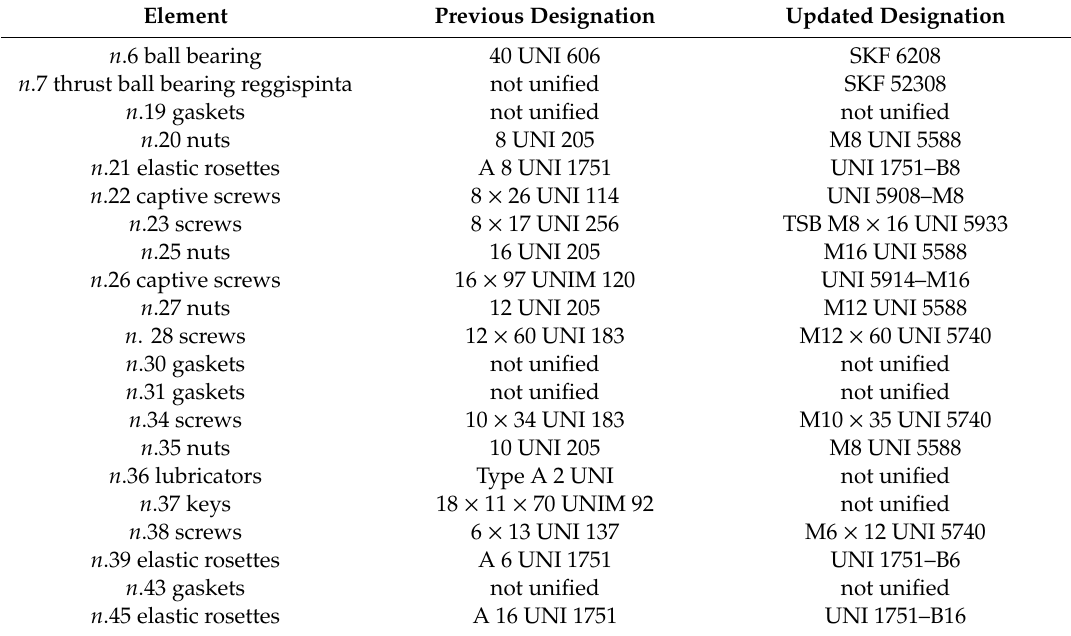
Table 1. Updating of the